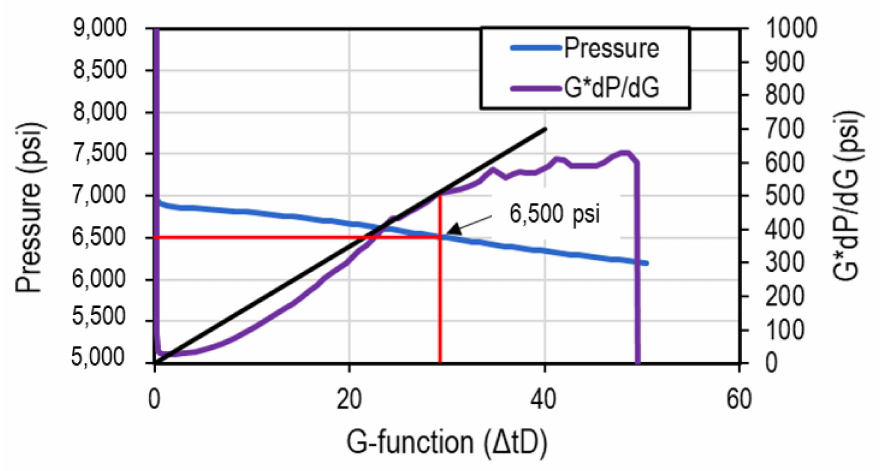
Figure 5. DFIT analysis using tangent method for Well #2 (Meramec Formation).